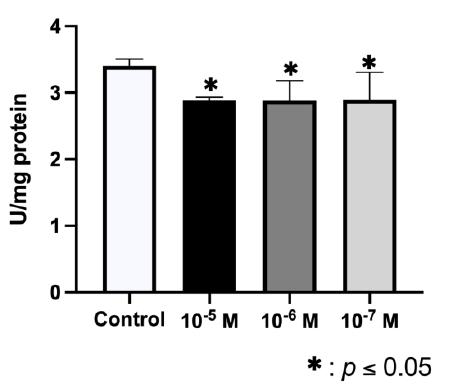
Figure 3. ALP activity of primary cell lines after 24 h of treatment with BPA at different doses of 10 −5 , 10 −6 , or 10 −7 M. The activity was determined in cell lysates and normalized to total cellular protein (U/mg of proteins). Data are reported as means ± standard deviation. Significant differences * p < 0.05.